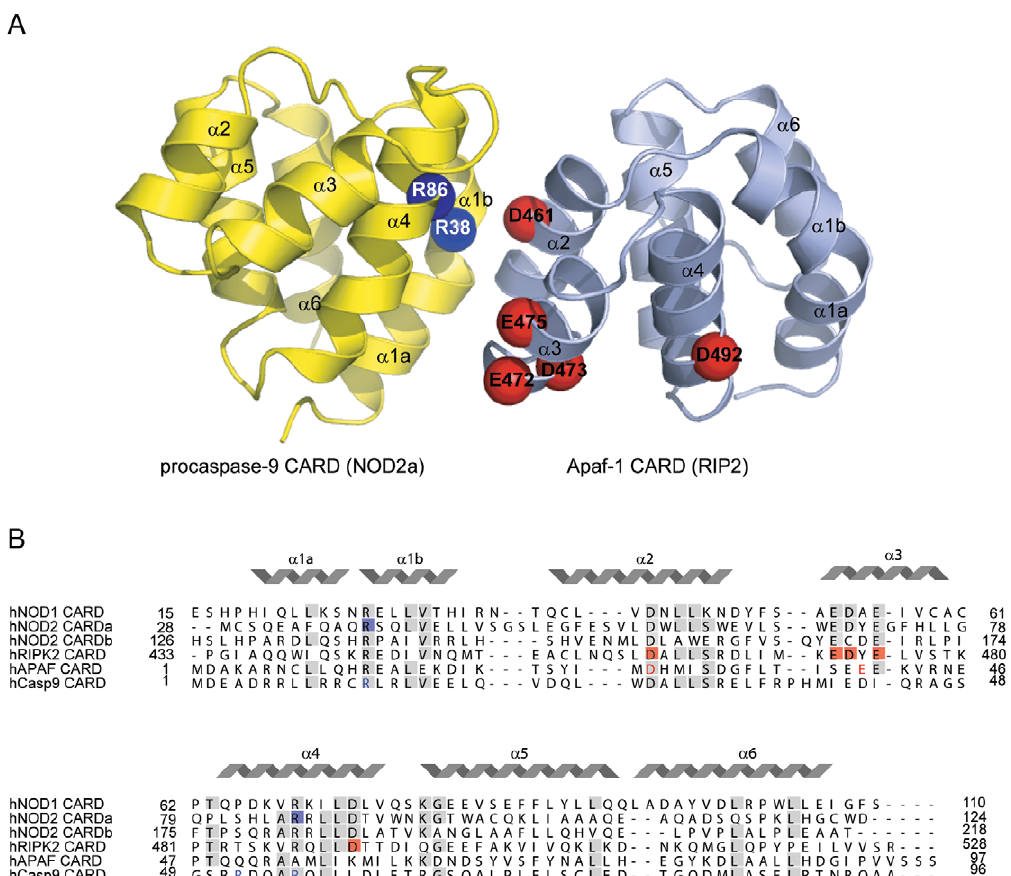
Figure 5. Residues involved in the NOD2-RIP2 interaction. (A) Structure of the CARD-CARD complex between Apaf-1 (light blue) and procaspase-9 (yellow), pdb ID 3YGS. The relative location of residues that were identified to disrupt the NOD2-RIP2 interaction has been mapped onto the CARD-CARD structure, based on the alignment shown in (B). These include R38 and R86 (shown in dark blue) located in CARDa of NOD2 that are shown mapped onto the CARD of procaspase-9 and D461, E472, D473, E475 and D492 in RIP2 (shown in red), mapped onto the CARD of Apaf-1. (B) The featured residues are highly conserved in CARDs. CARDa R38 and R86 correspond to two (R13 and R56) of the three basic residues in procaspase-9 (shown in blue) that are crucial for the interaction with Apaf-1. CARDa has no equivalent to the third residue, R52. Conversely, RIP2 CARD D461 corresponds to Apaf-1 D27 and RIP2 E472, D473 and E475 are located in the region of Apaf-1 E40. Apaf-1 D27 and E40 (shown in red) are both crucial for the interaction with